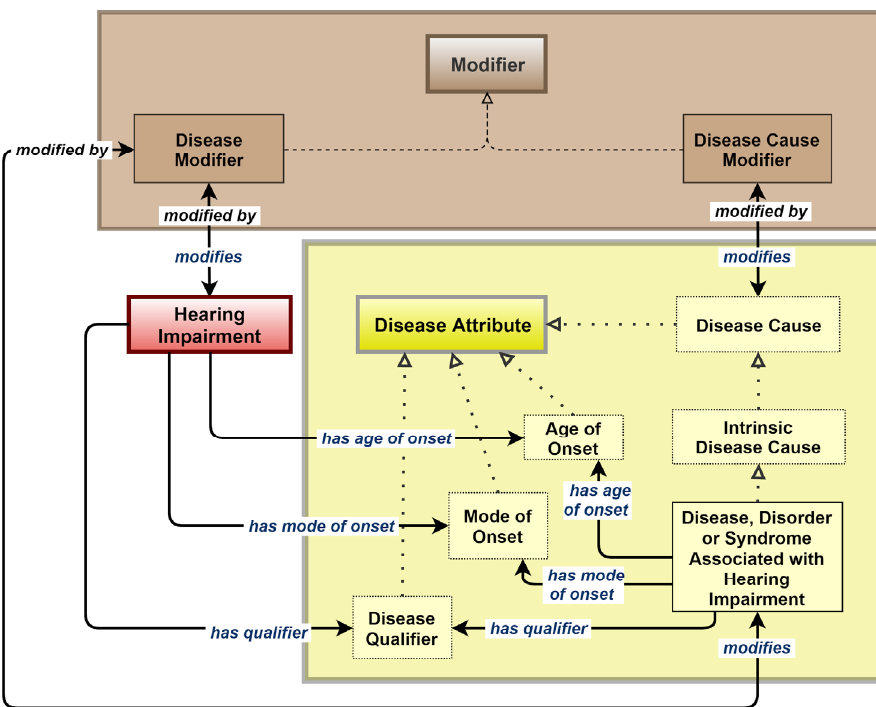
Figure 7. Associations made in the HIO to and from the ‘Modifier’ and ‘Disease Attribute’ classes, excluding those already shown in Figure 5 for the ‘Disease Cause’ class.